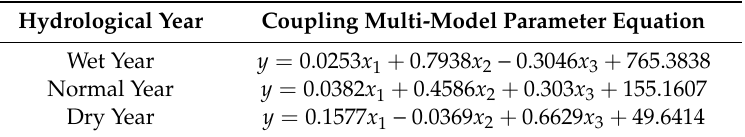
Table 5. Coupling multi-model parameter equations corresponding to di ff erent hydrological years (note: y means the annual runo ff predicted by the coupling model. x 1 , x 2 , x 3 mean the annual runo ff predicted by the BPNN model, the ENN model, and the PSO-SVR model,